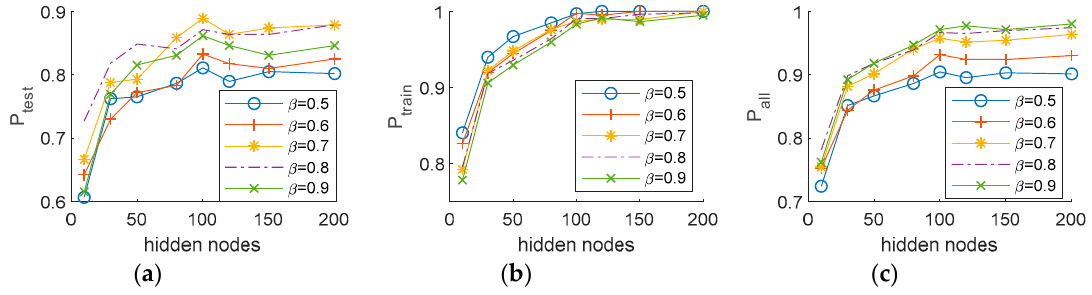
Figure 9. The curve of accuracy changing with the number of hidden nodes in CNN at different β . The horizontal axis in the figure represents the hidden nodes in CNN. The vertical axis represents the recognition accuracy: ( a ) The accuracy of the test set; ( b ) The accuracy of the training set; ( c ) The accuracy of all images.